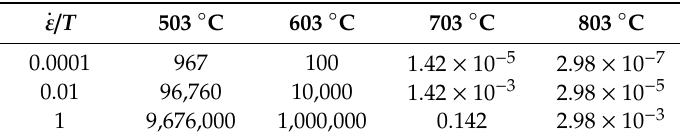
Table 2. Flow stress σ for K9 optical glass.